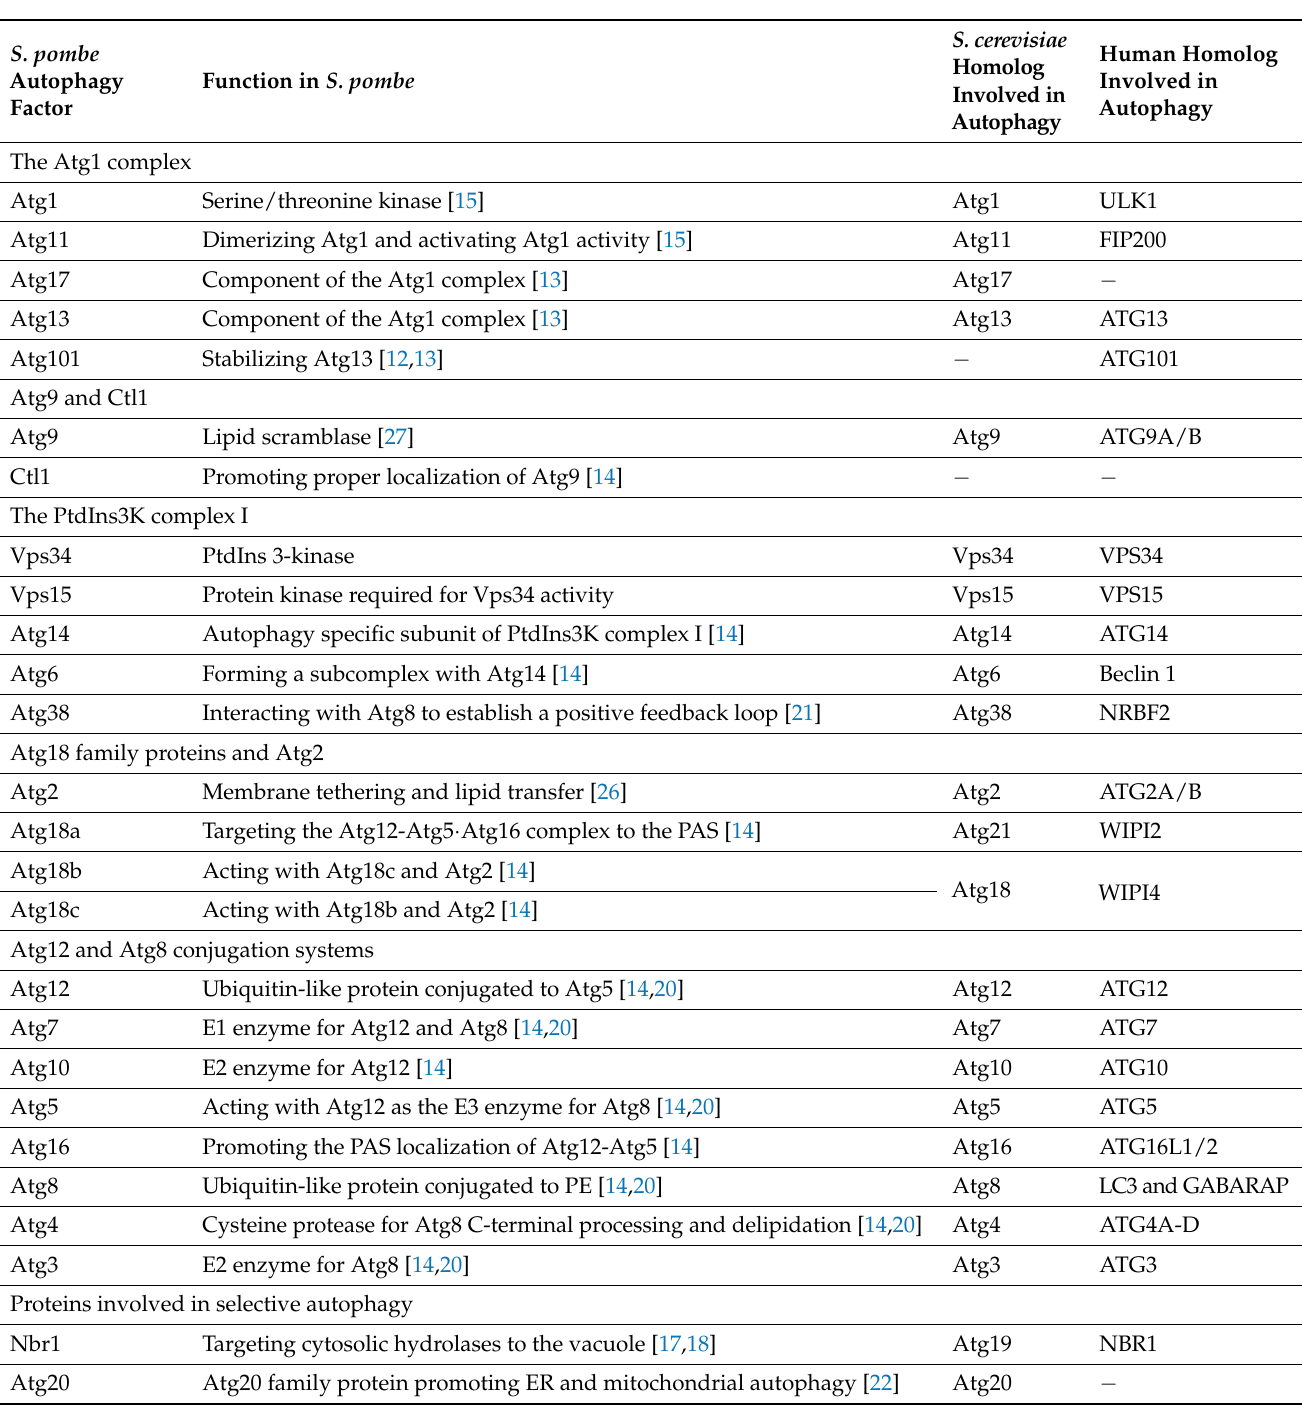
Table 1. Autophagy factors in S. pombe